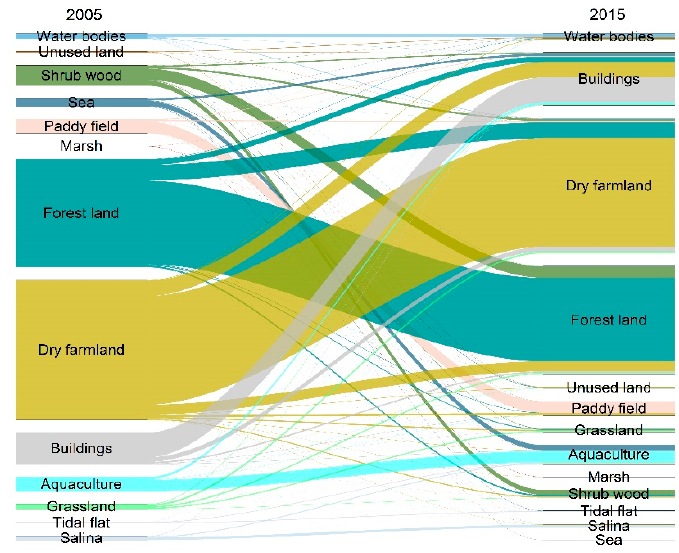
Figure 9. Land-use changes in Dalian from 2005 to